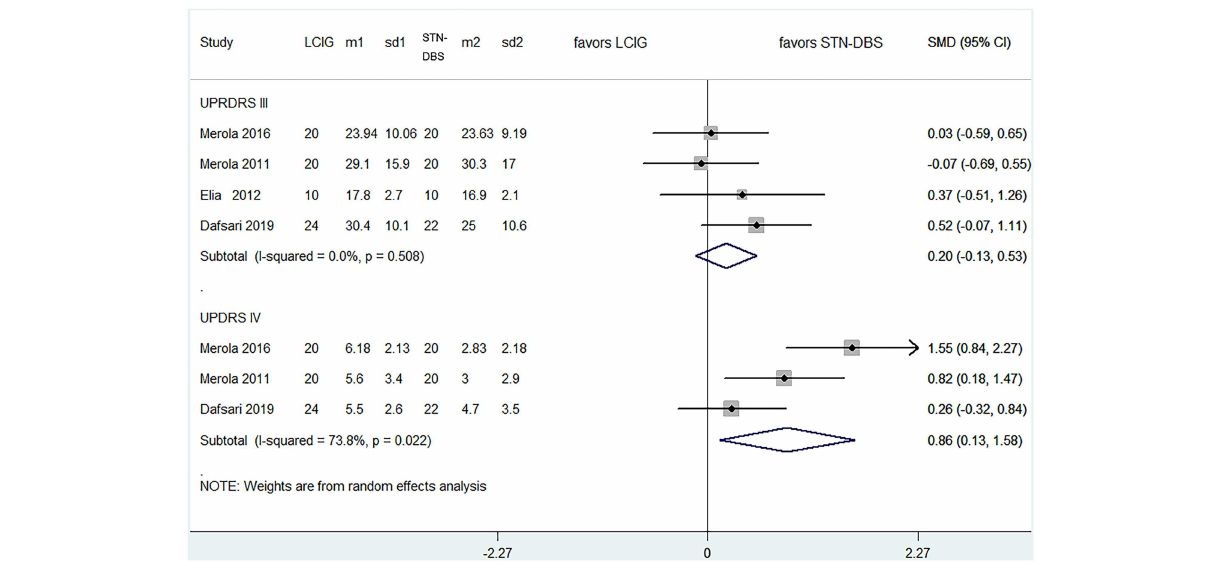
FIGURE 2 | Comparisons between LCIG and STN-DBS for UPDRS III, UPDRS IV. LCIG, Levodopa/carbidopa intestinal gel infusion; STN-DBS, Subthalamic nucleus deep brain stimulation; m, mean; sd, standard